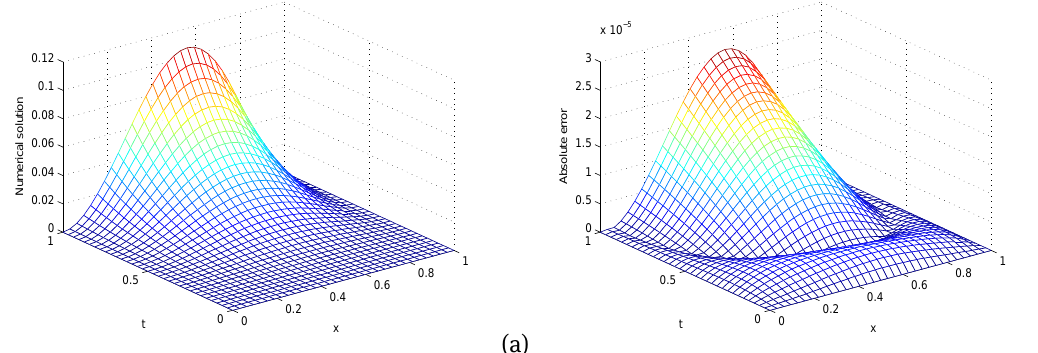
Figure 1: Numerical solution (a) and global error (b) for Example 1 with γ = 1.3, h = 1/32, τ = 1/32